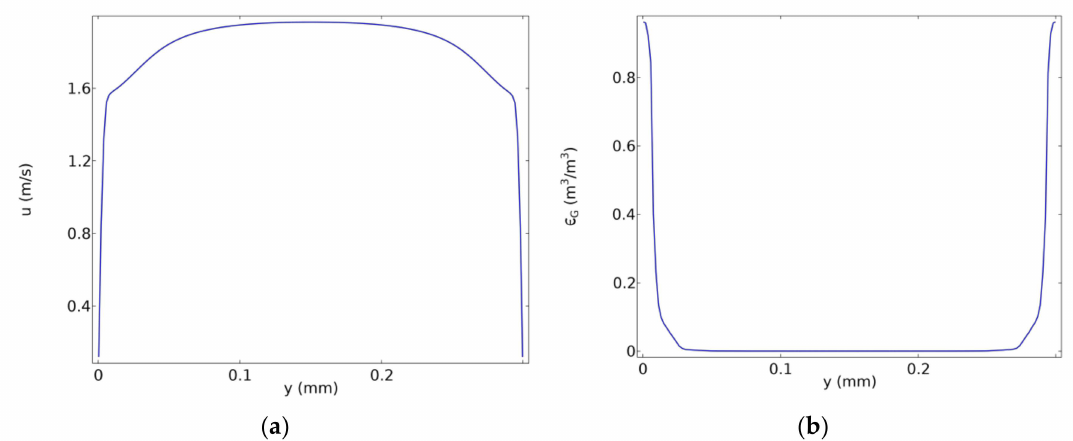
Figure 3. Transverse velocity ( a ) and void fraction ( b ) profiles in the microchannel. Boiling heat transfer in the microchannel. Transverse section z = L/2.